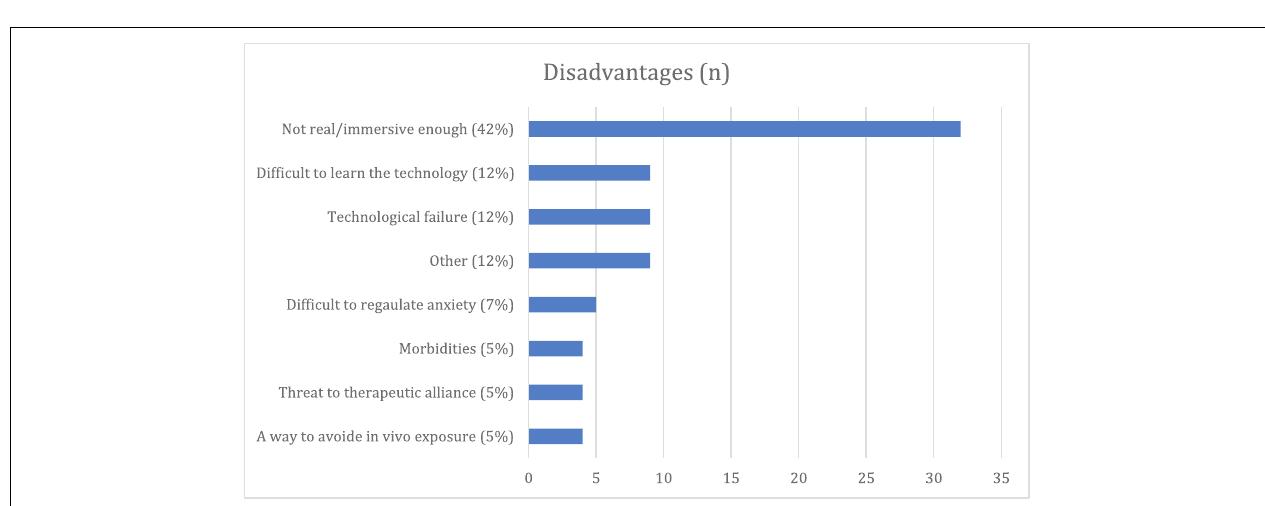
FIGURE 5 | Clinicians’ perceived disadvantages of using VR in therapy before the intervention. Not real/immersive enough, low degree of realism and generalizability to real-world settings; Difficult to learn the technology, worries that it will be difficult learning to operate the equipment; Technological failure, worries that the equipment could malfunction; Other, a residual category for items with low frequency of occurrence; high cost of equipment ( n = 3), cybersickness ( n = 3), not more effective than regular in vivo treatment ( n = 1), not enough research on VRET ( n = 1), few patients with specific phobias are treated at general outpatient clinics ( n = 1); Difficult to regulate anxiety, no easy way to control the degree of exposure; Morbidity, unfit to use on people with diagnoses like psychosis or other limitations like impaired hearing and/or vision; Threat to therapeutic alliance, potential barrier between clinician and client; A way to avoid in vivo exposure, allowing the patient to avoid exposure to real-world